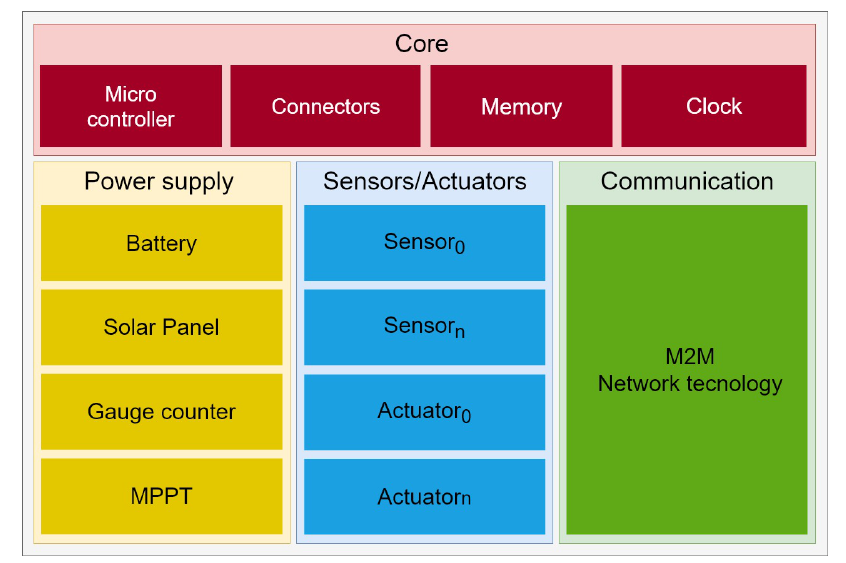
Figure 1. Different hardware concepts that compose the IoT